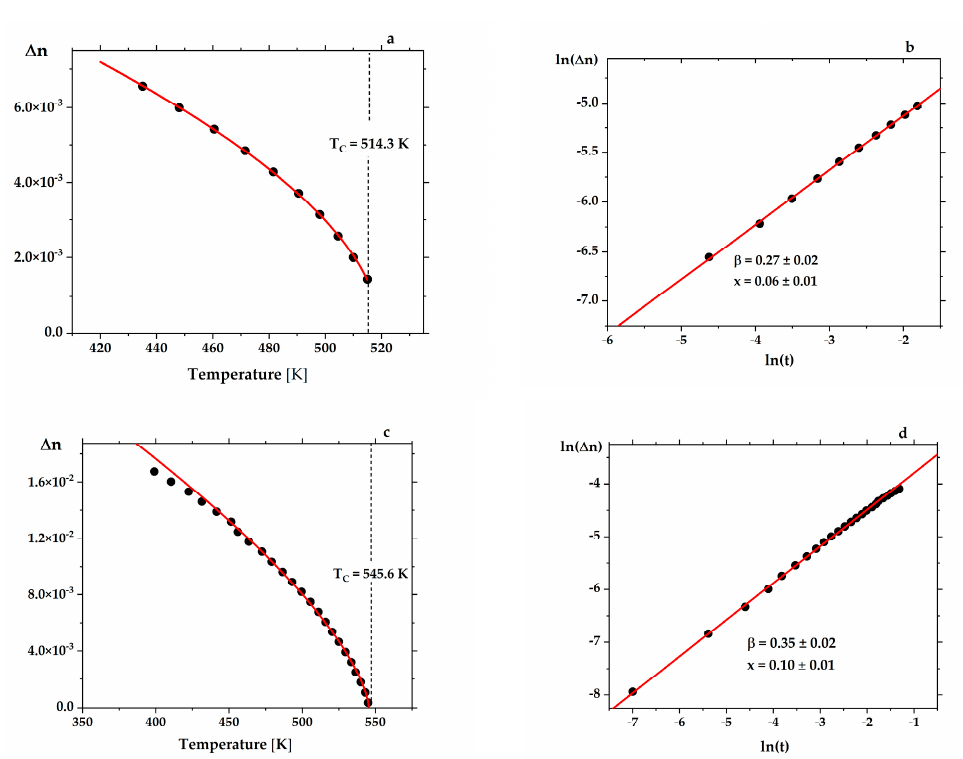
Figure 3. Temperature dependence of birefringence ∆ n for 500 µ m thick PbZr 0.96 ± 0.01 Ti 0.04 ∓ 0.01 O 3 ( a ) and 400 µ m thick PbZr 0.90 Ti 0.10 O 3 ( c ); logarithmic dependences of the birefringence ∆ n versus re- duced temperature t allow for determining the exponent β ( b , d ). The red curves fit the relation (3), and the value of T C was found from the best linear least-squares fit to the logarithmic depen- dence. The calculated values of the Curie point correspond closely to those determined from the dielectric measurements for the same samples (see Figure 1). For a crystal with x = 0.06 ± 0.01, the β value equal to 0.27 ± 0.02 confirms its tricritical behavior ( b ). The birefringence curve for PbZr 0.90 Ti 0.10 O 3 crystal corresponds to that for a second-order phase transition, as previously re- ported by Glazer et al. [44] ( d ). The value β = 0.35 ± 0.02 obtained for this crystal is almost the same ( β = 0.33) as that found by Clarke and Glazer